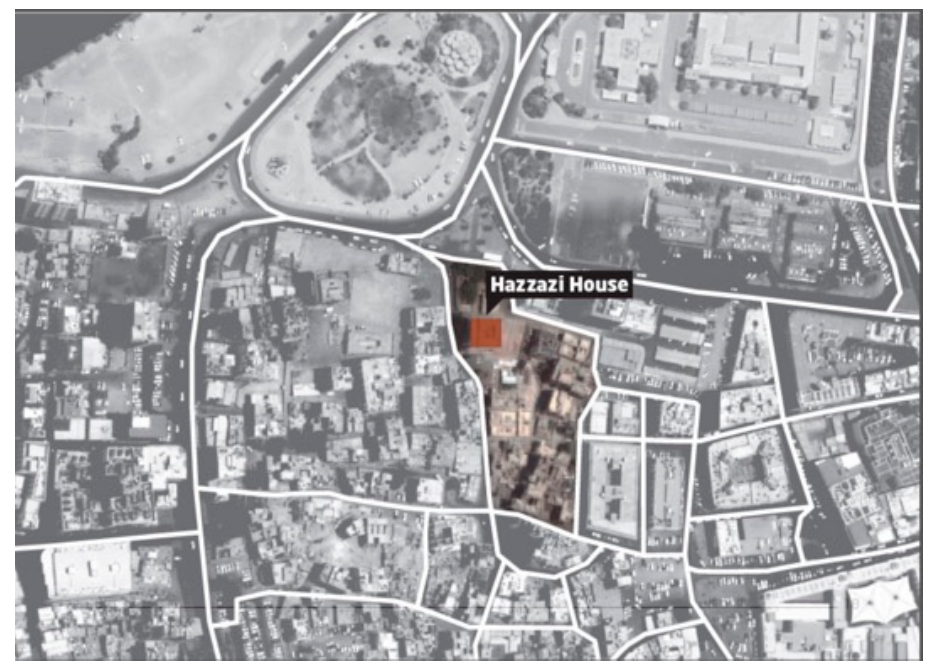
Figure 1. Hazzazi House Location in Old Jeddah Neighborhoods.